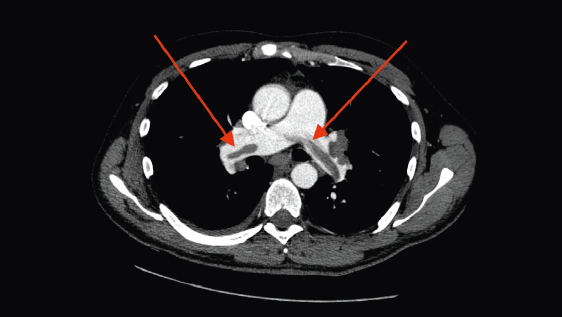
Figure 2: Chest angiotomography showing saddle pulmonary